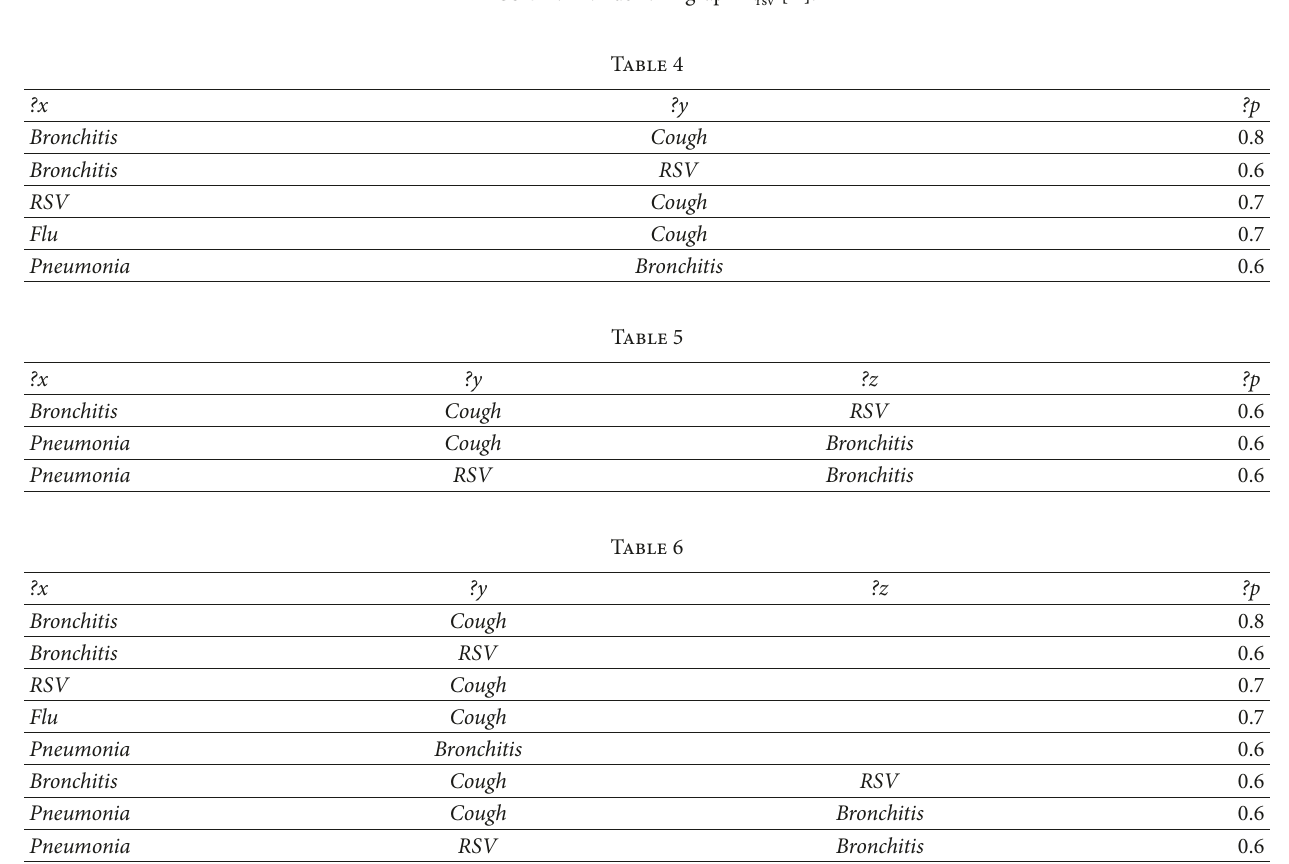
Figure 1: A virus RDF graph R rsv